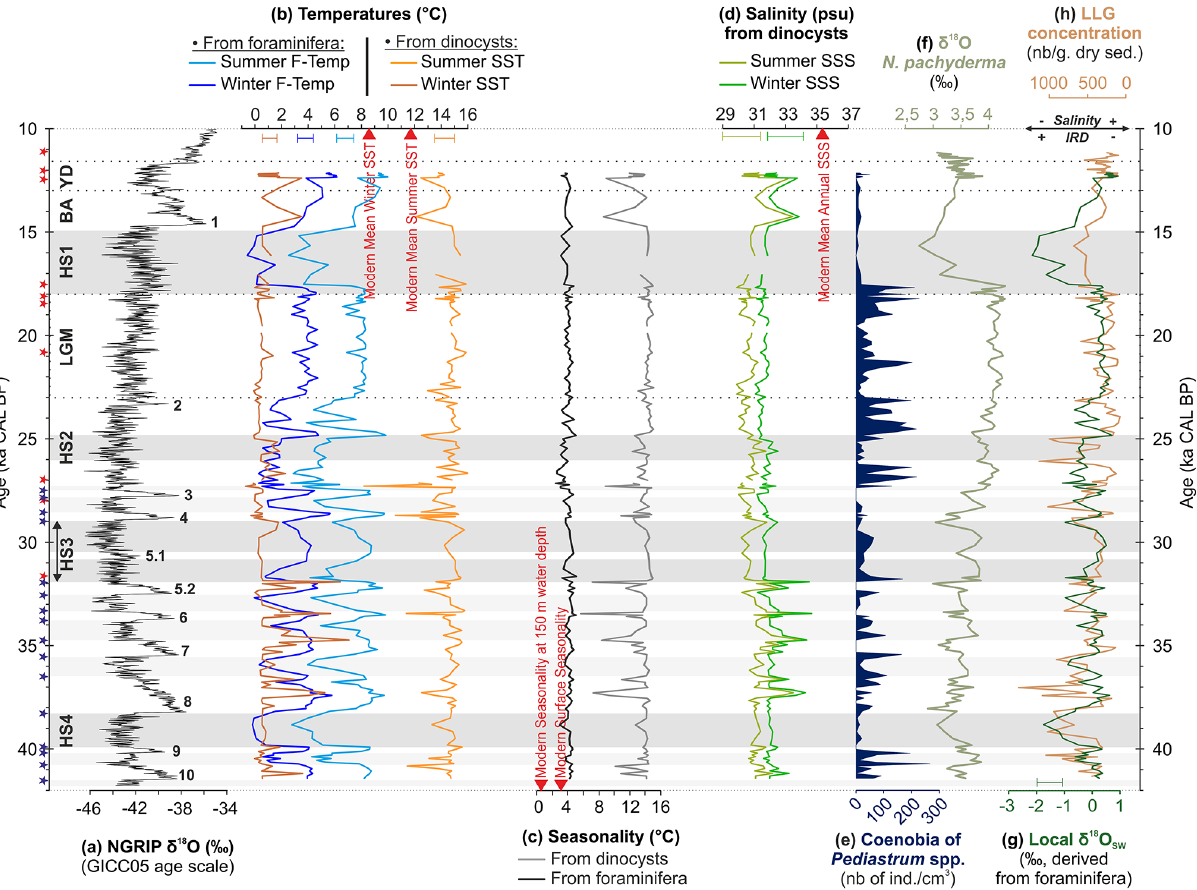
Figure 3. Reconstructed hydrological parameters derived from dinocyst and planktonic foraminifera assemblages compared to (a) NGRIP- GICC05 δ 18 O record: (b) temperatures, (c) seasonality (mean summer minus mean winter temperatures), (d) SSS derived from dinocysts, (e) Abundances of coenobia of the freshwater algae Pediastrum spp., (f) δ 18 O measured on N. pachyderma , (g) local δ 18 O SW derived from δ 18 O on N. pachyderma , and (h) large lithic grain (LLG) concentration, plotted on a reverse scale. Stars, bands, DO number and acronyms: same legend as Fig.